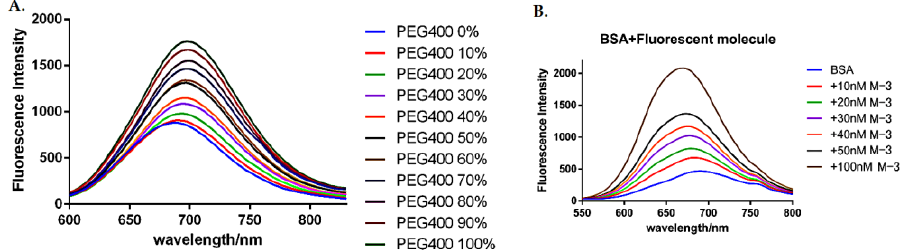
Figure 4. ( A ) Fluorescence emission spectrum of M-3 in different viscosity conditions; ( B ) Fluores- cence emission spectrum of M-3 combining with BSA.